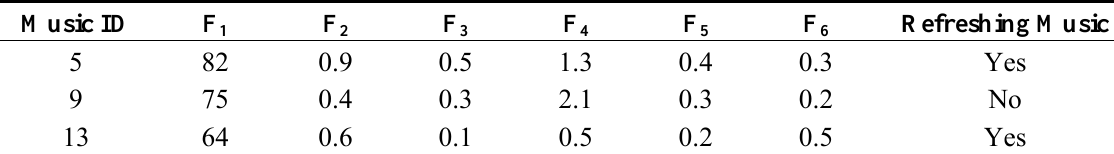
, F , …, F are the music features. 1 2 6